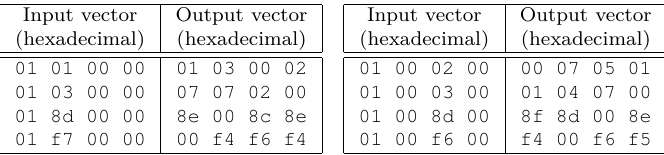
Table 6: Representatives of pessimal diffusion of AES diffusion matrix.